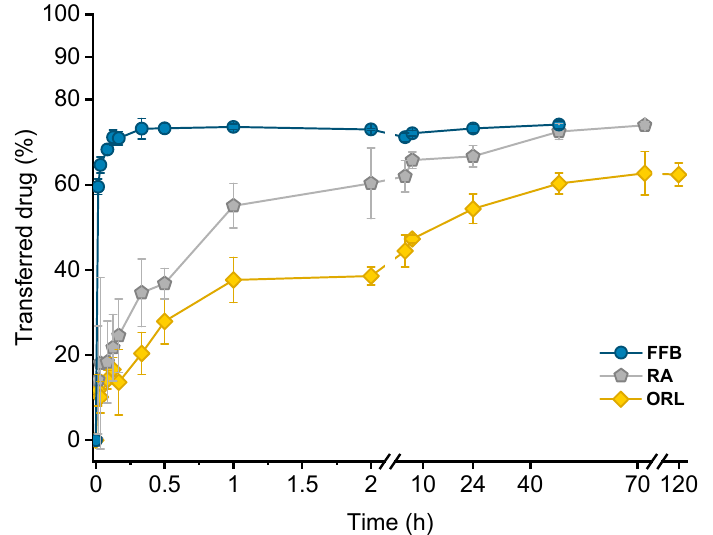
Figure 5. Drug transfer into CNTM-containing hydrogel beads. Each value represents mean ± SD ( n = 3). Abbreviations: FFB—fenofibrate, RA—retinyl acetate, ORL—orlistat.